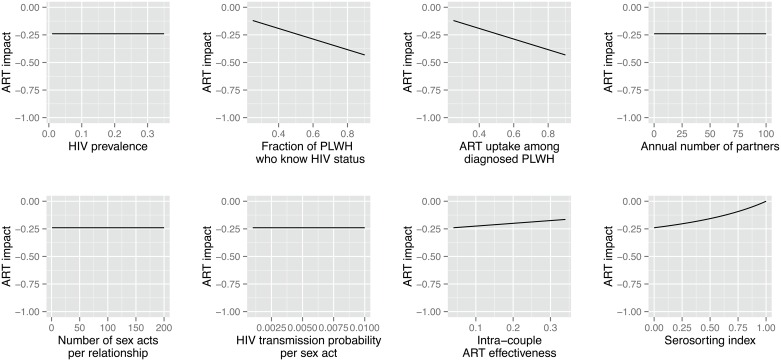
Population-level impact of ART on HIV incidence, as a function of the model parameters (one-way analysis).Notes: The impact of ART on HIV incidence is defined as the relative change in the HIV incidence rate, associated with ART (I/InoART − 1). An ART impact of 0 thus indicates no effects of ART on HIV incidence, whereas an ART impact of -1 indicates that ART eliminates HIV incidence.